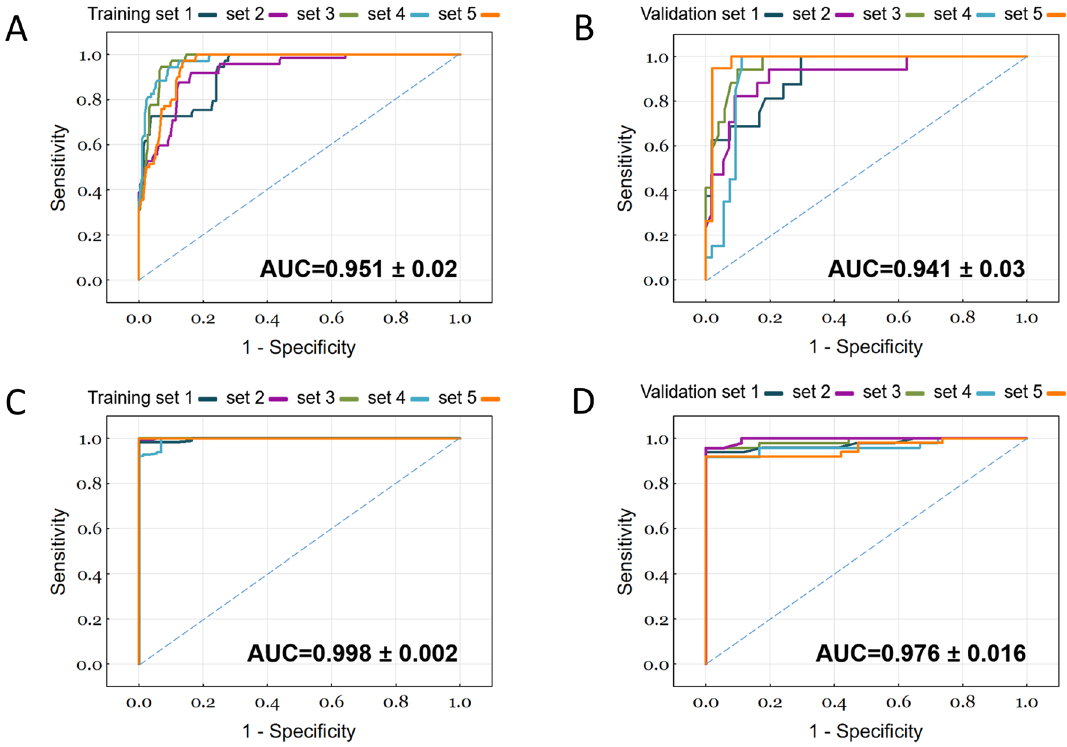
Figure 3. Predictive performance of the ANN models. Visualization of the ROC curves and AUC of the five ( A ) training and ( B ) validation sets used in the ANN model 1 to predict the post-tPA sICH of patients with AIS. Visualization of the ROC curves and AUC of the five ( C ) training and ( D ) validation sets used in the ANN model 2 to predict the post-tPA 3-month mortality of patients with AIS. The AUC value represents the mean ± SD of the AUC of the five training and validation sets. ANN, artificial neural network; AUC, area under the receiver operating characteristic curve; ROC, receiver operating characteristic; tPA, tissue plasminogen activator.